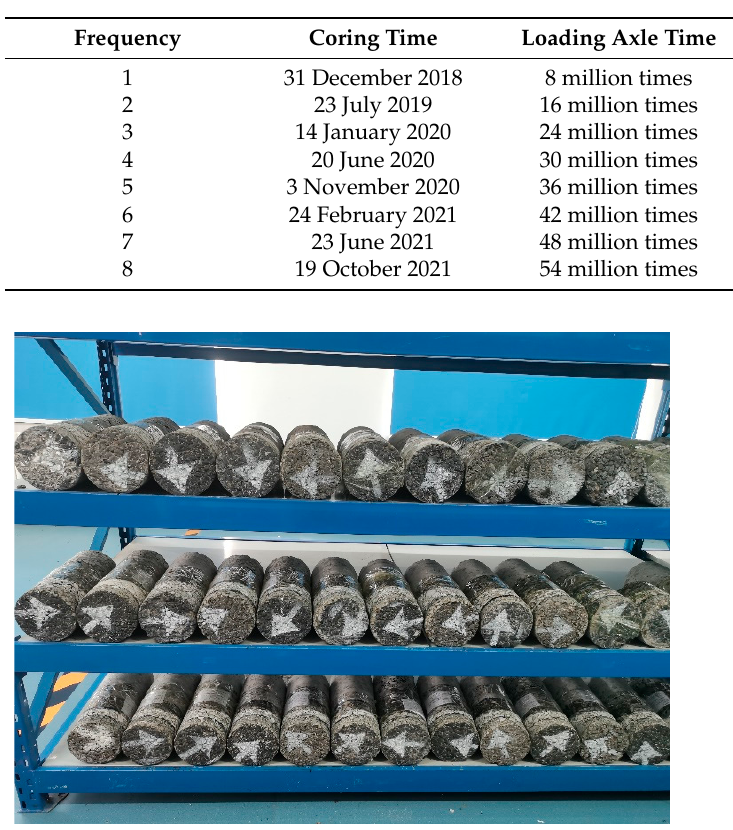
Table 1. RIOHTrack coring information.